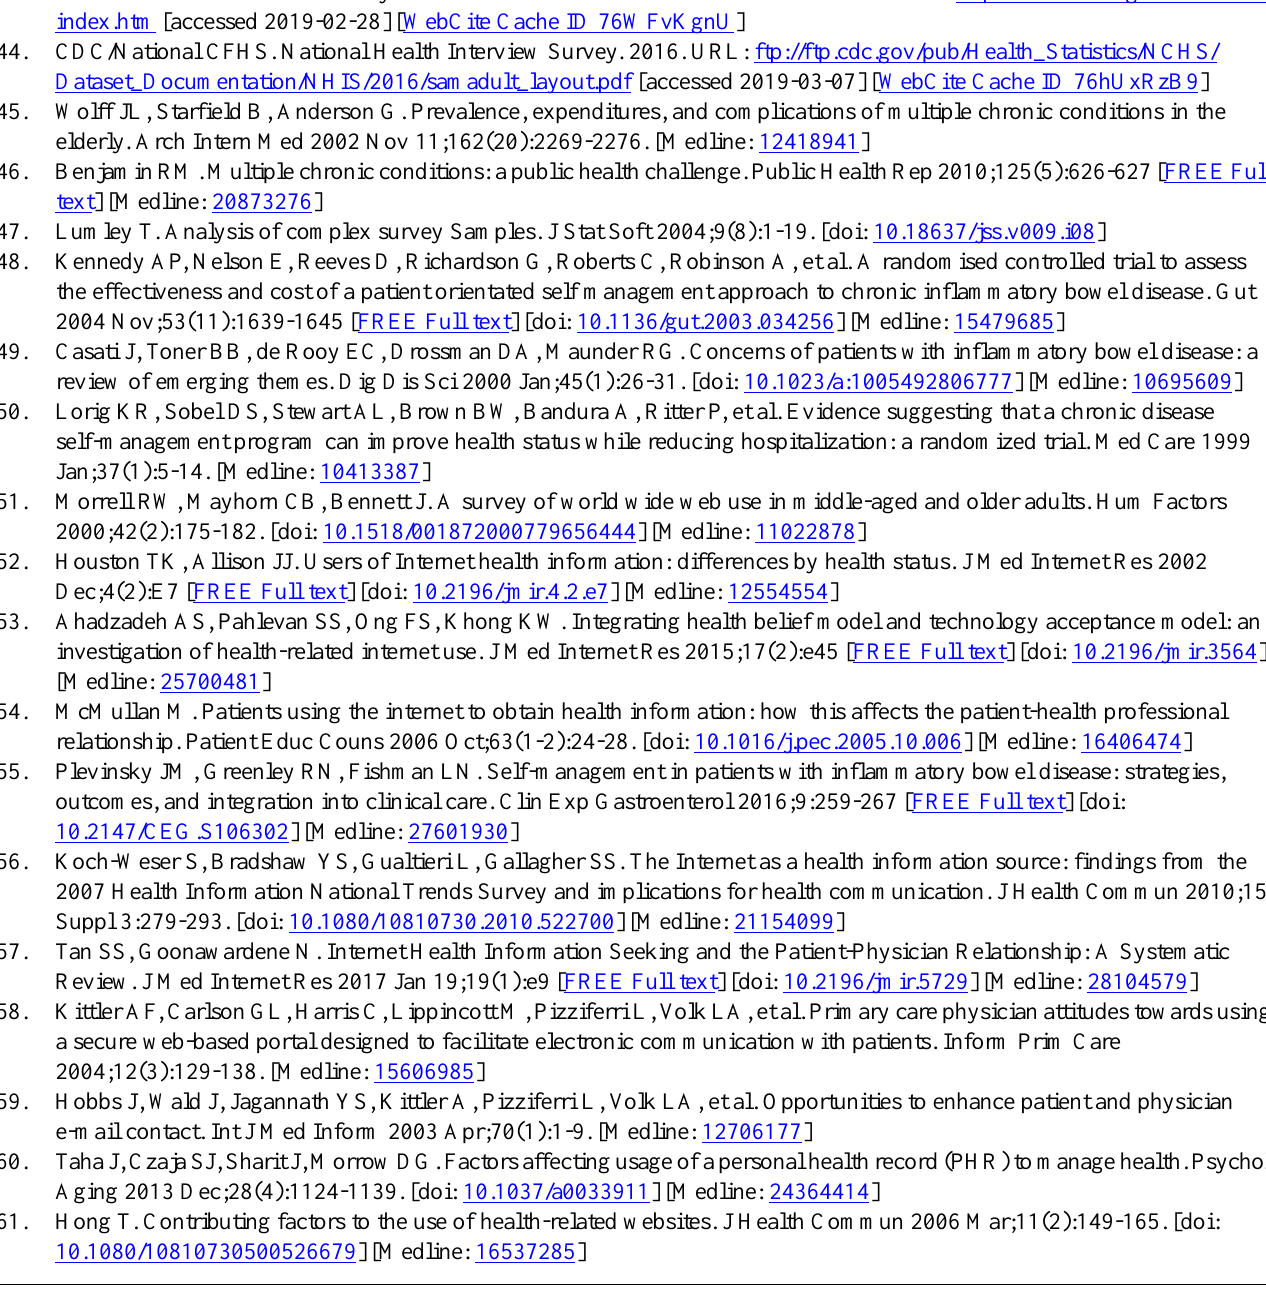
IBD: inflammatory bowel disease OR: odds ratio NHIS: National Health Interview